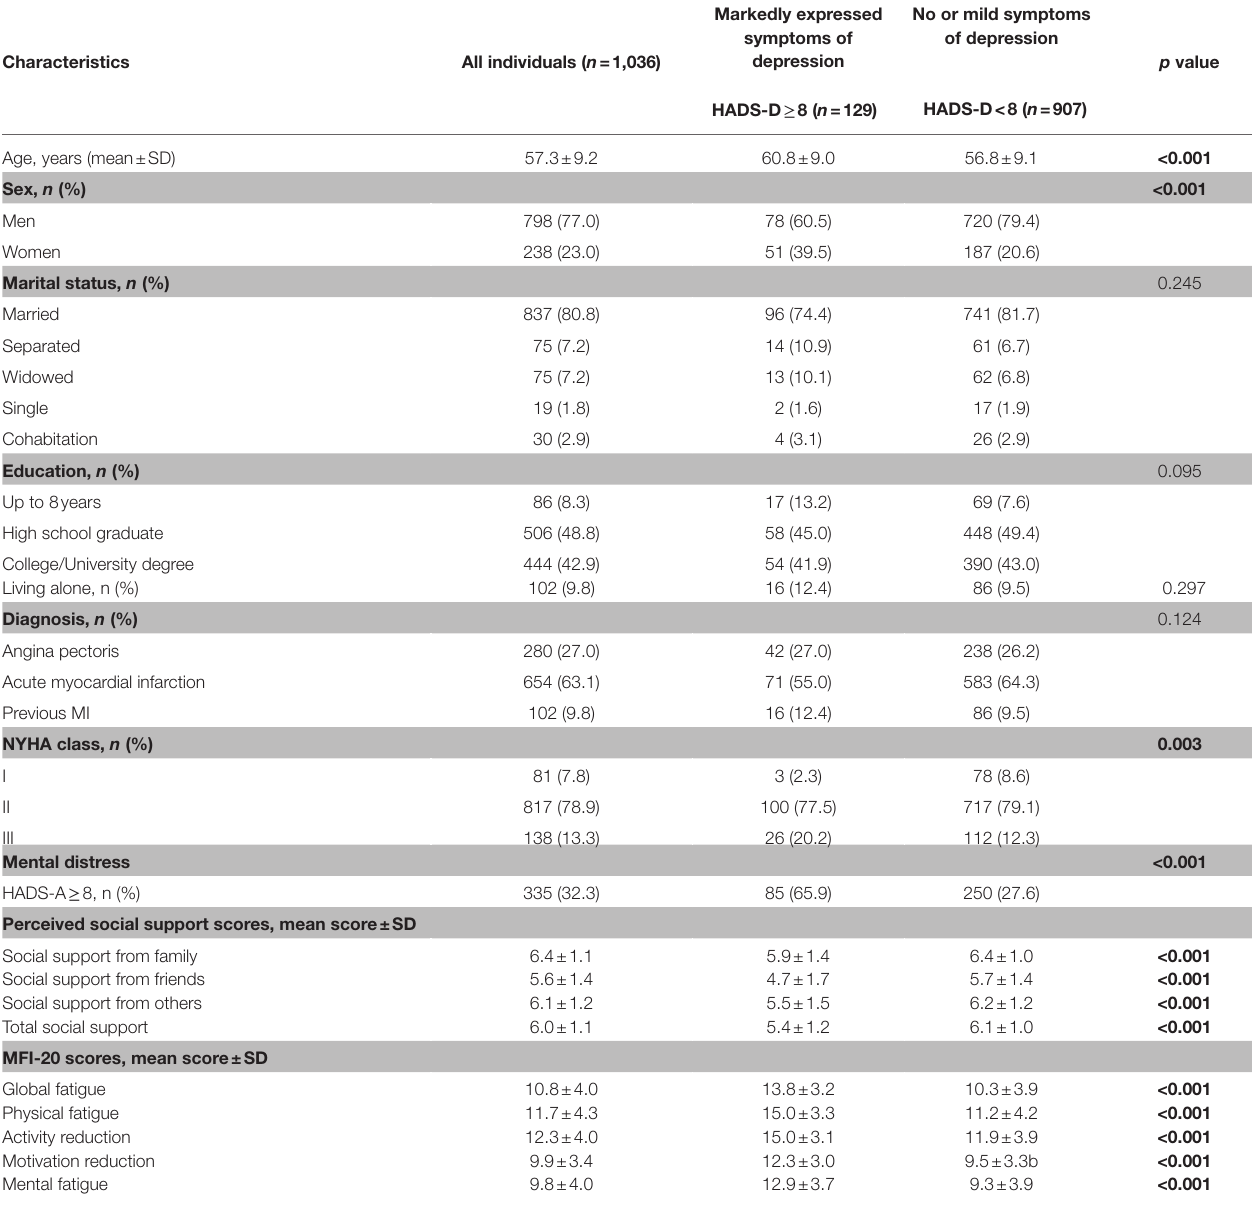
TABLE 1 | Characteristics of all individuals after acute coronary syndromes (ACSs) at inclusion stratified by depression symptoms.